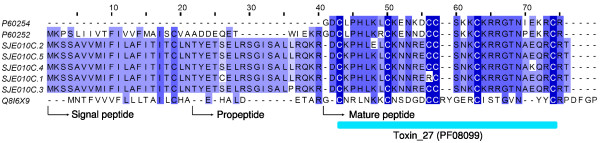
Sequence alignment of calcines. SJEs are clusters from this work. The others are P60252 (Opicalcin-1, Opistophthalmus carinatu), P60254 (Maurocalcin, Scorpio maurus palmatus), and Q8I6X9 (BmCa-1, Mesobuthus martensii).